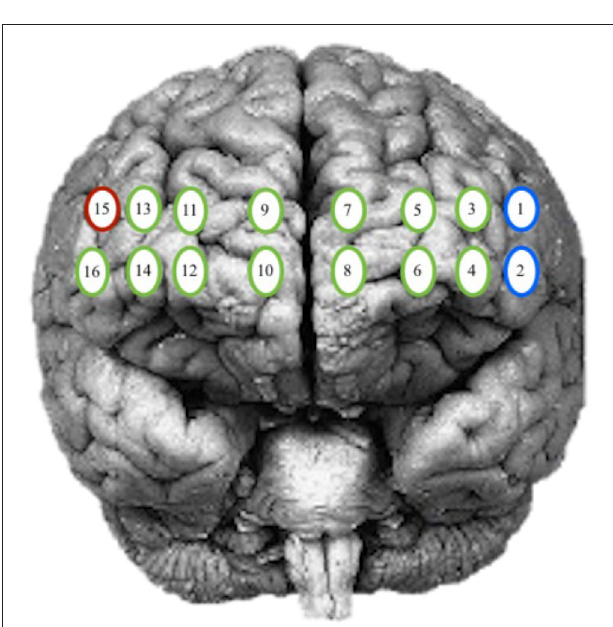
FIGURE 3 | Optode grouping for regions of interest. Red, Broadmann’s Area 9; Green, Broadmann’s Area 10; Blue, Broadmann’s Area 46.